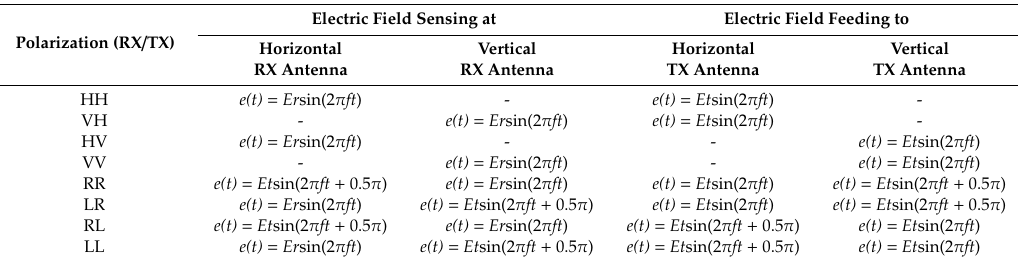
Table 3. Practical wave feeding, wave sensing, and phase shifting for LP and CP modes. Please notice the di ff erent arrangements of phase shifting for the receiver (RX) right-handed transmitter (TX) right-handed (RR), RX left-handed TX right-handed (LR), RX left-handed TX right-handed (LR), or RX left-handed TX left-handed (LL) modes compared to Table 3.